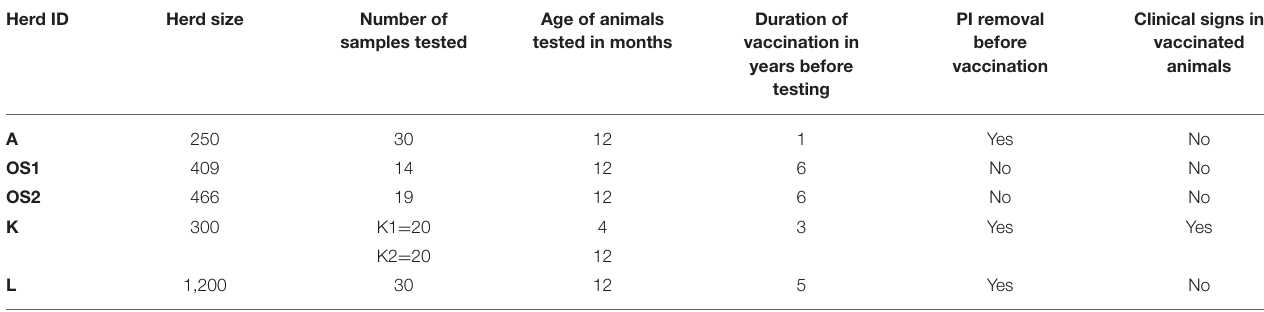
TABLE 1 | Detailed information on animals included in the study. Herd ID Herd